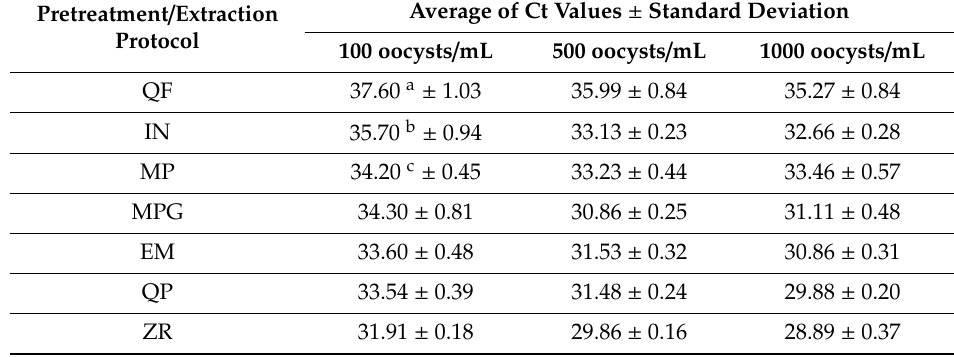
Table 7. Average of Ct values and standard deviation of real-time PCR results according to the pretreatment / extraction protocol and to oocyst